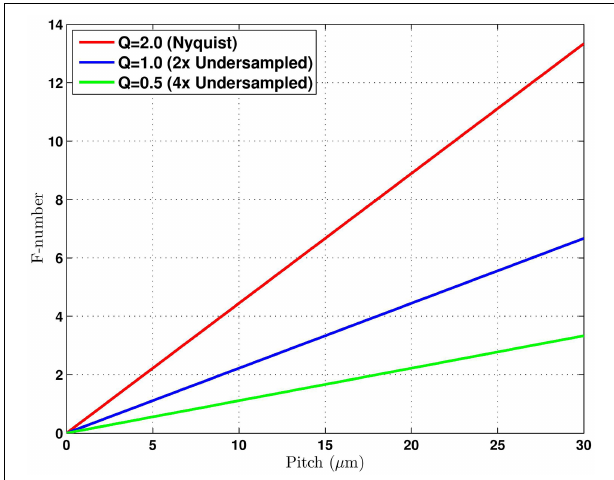
FIGURE 4 | Sampling relationship between pitch and f-number for λ = 4 . 5 μ m. Three Q -values curves are shown where Q = λ F / p